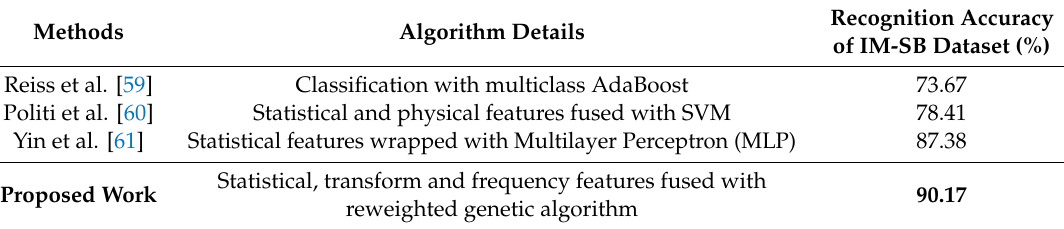
Table 11. Comparison of the proposed method with other methods using the IM-SB